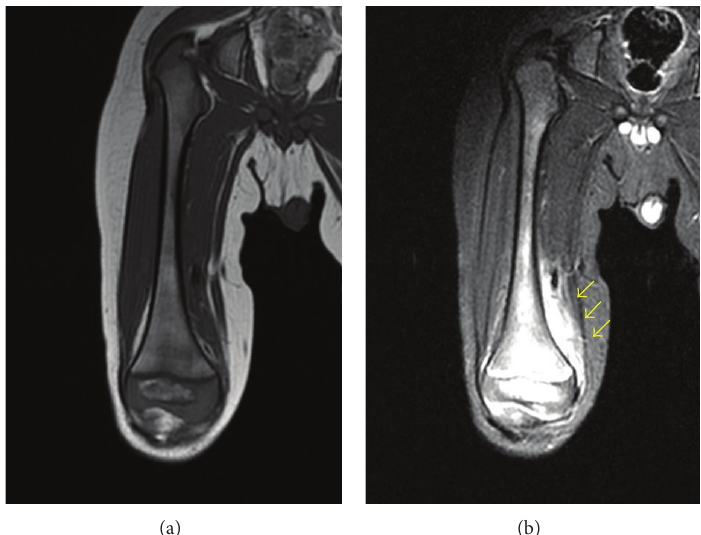
Figure 1: (a) Coronal T1-weighted image of the right femur shows hypointensity in the bone marrow of femoral diaphysis and epiphysis. (b) Coronal STIR sequence shows hyperintensity in the bone marrow of the femoral diaphysis and epiphysis, including the area around the soft tissue.